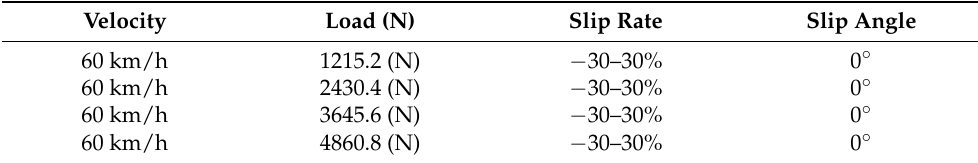
Table 2. Tire force pure longitudinal slip test